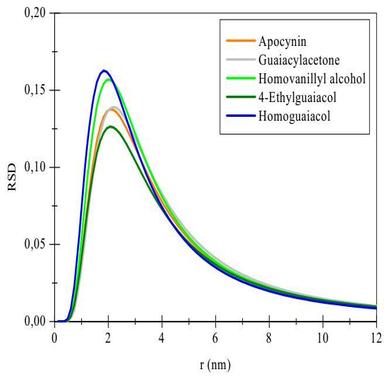
Olfactory receptor site size distributions (RSDs) of the mouse eugenol olfactory receptor mOR-EG.